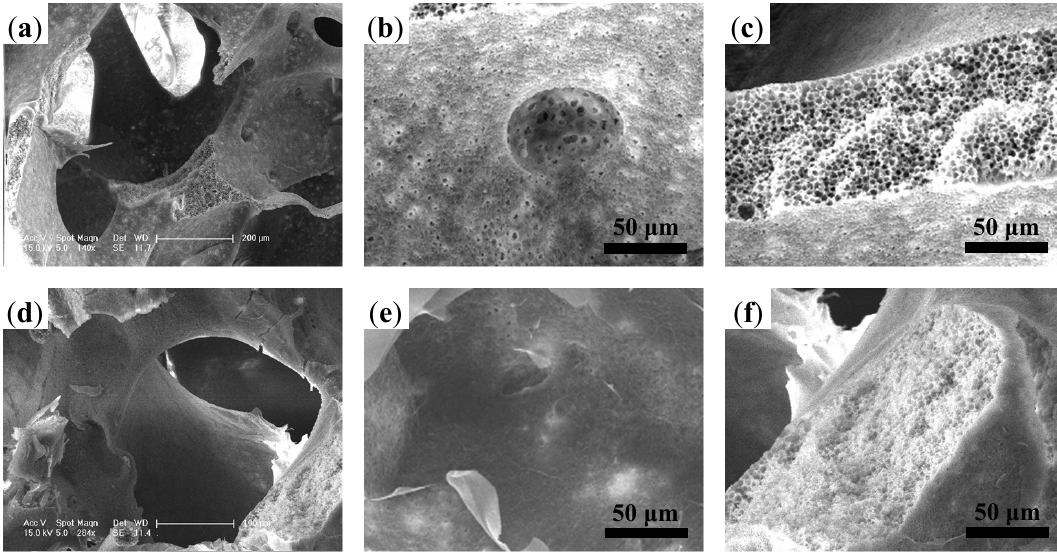
Figure 2. SEM microimages of internal structures for ( a – c ) porous PLGA scaffold and ( d – f ) PLGA scaffold with gelatin